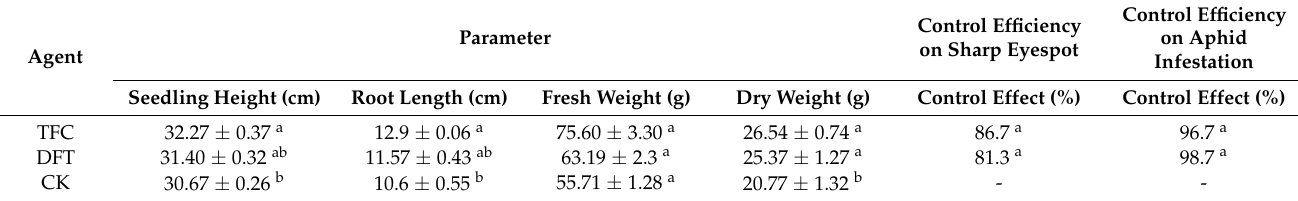
Table 4. Effect of TFC and DFT in the